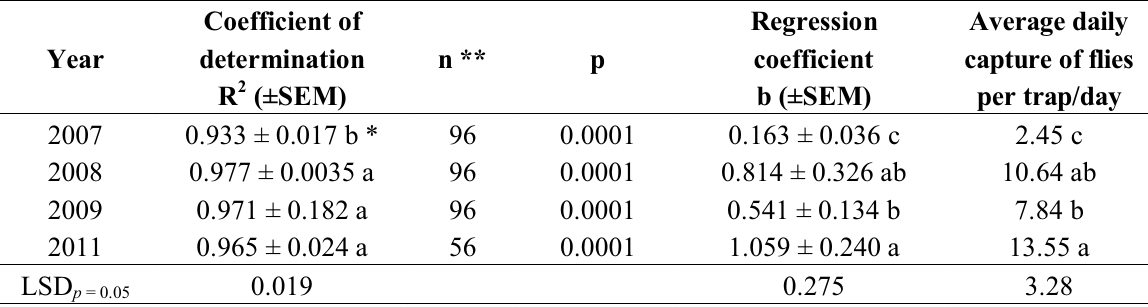
Table 4. Data obtained in the linear regression analysis (coefficients of determination (±SE), probability, n , and regression coefficients (±SE) of the degree-day accumulations (above 4.3 °C and below 30 °C) (x) versus the cumulative number of Delia radicum (L.) flies /yellow sticky trap (y) over four field seasons (2007 to 2009,